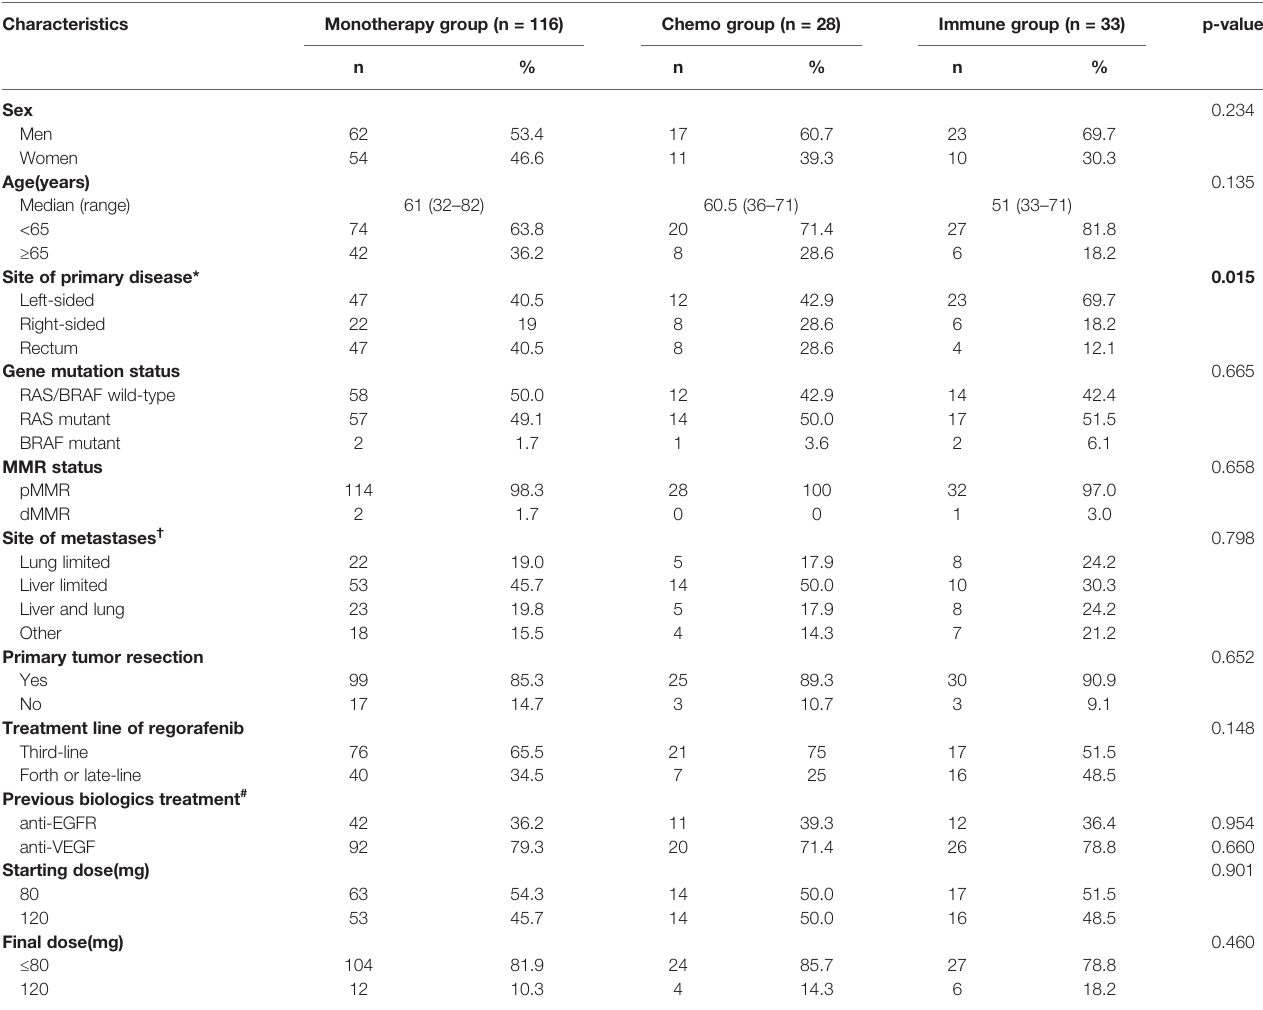
TABLE 2 | Baseline demographic and clinical characteristics of 3 study cohorts.